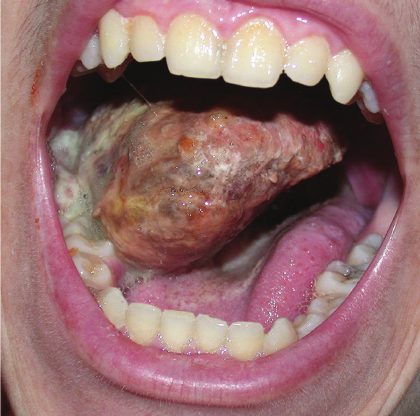
Figure 1: Oral examination showed a mass with nodular tissue causing severe dysphagia and respiratory distress.